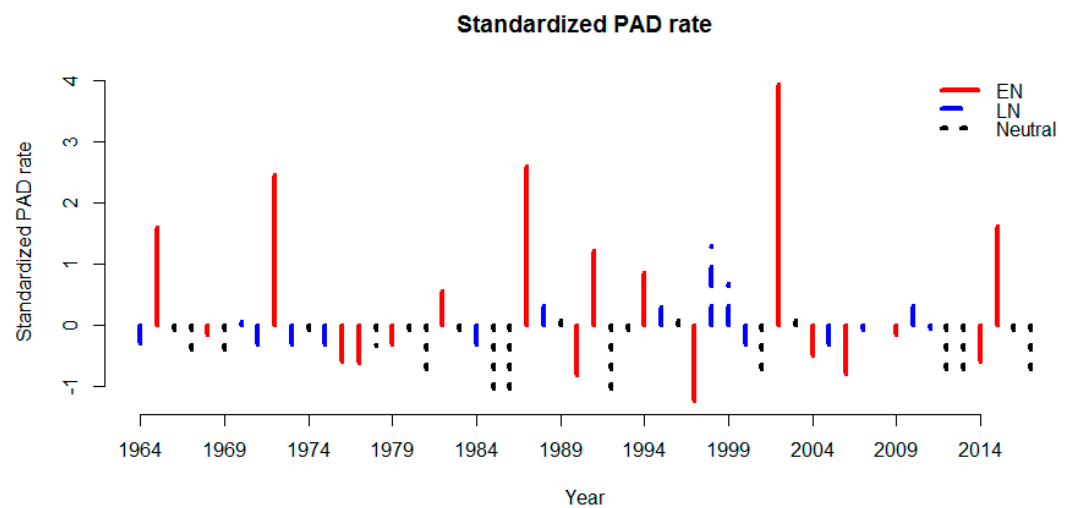
Figure 2. Standardized detrended global PAD rate by year, 1964–2017. Years indicated by solid line, dashed line and dotted line represent El Niño (EN), La Niña (LN) and neutral years [6], respectively.